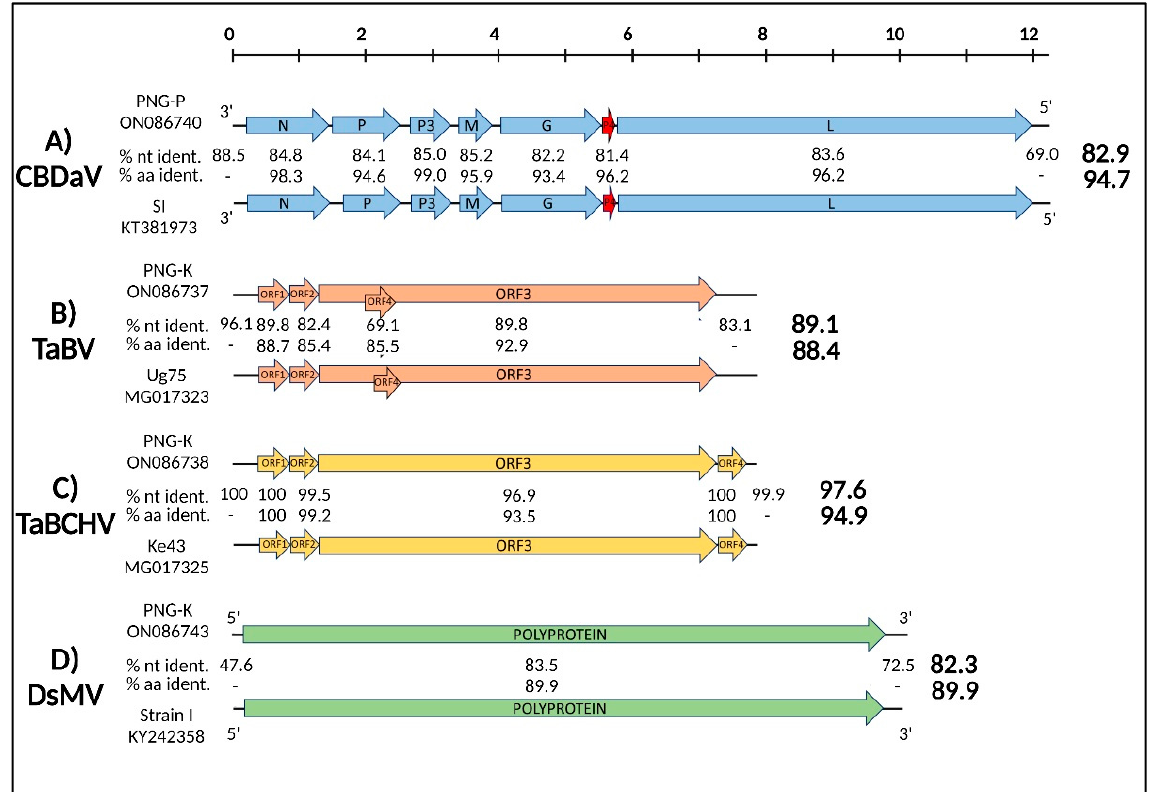
Figure 2. Genomic organization and nucleotide and protein identities of representative virus isolates from Papua New Guinea (PNG) of Colocasia bobone disease-associated virus (CBDaV) ( A ), taro bacilliform virus (TaBV) ( B ), taro bacilliform CH virus (TaBCHV) ( C ), and dasheen mosaic virus (DsMV) ( D ) with their closest homologs. Open reading frames (ORFs) are represented by light-colored arrows. A new proposed ORF (P4) found in CBDaV in two isolates from PNG and one isolate from the Solomon Islands is in red. The overall nucleotide and protein identities are located to the right of each virus genome representation. The virus strain names and their respective GenBank accessions are provided. Genomes and ORFs are to scale.